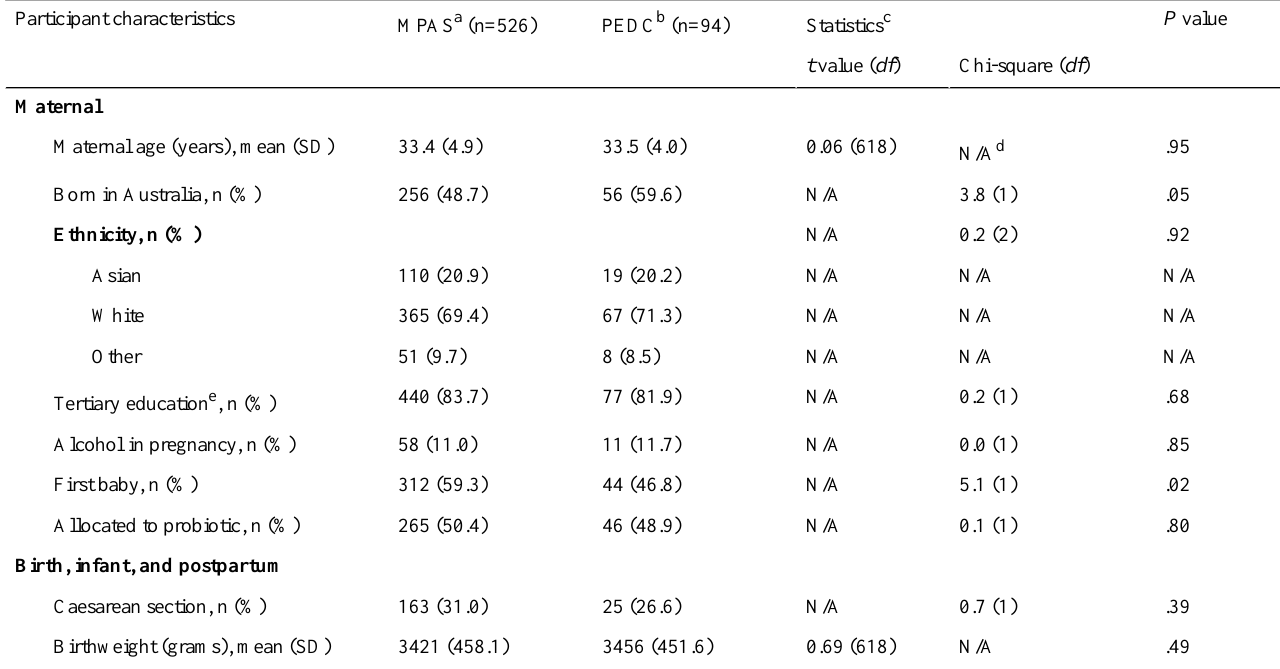
Table 1. Characteristics of participants using the mobile phone automated system compared with the paper and email data collection